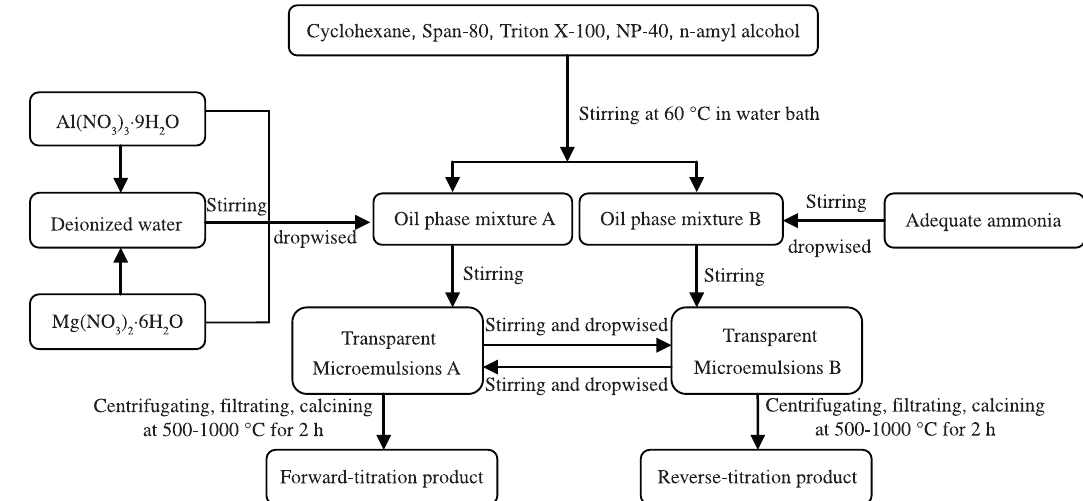
Figure 1. Schematic diagram of synthesize of MgAl